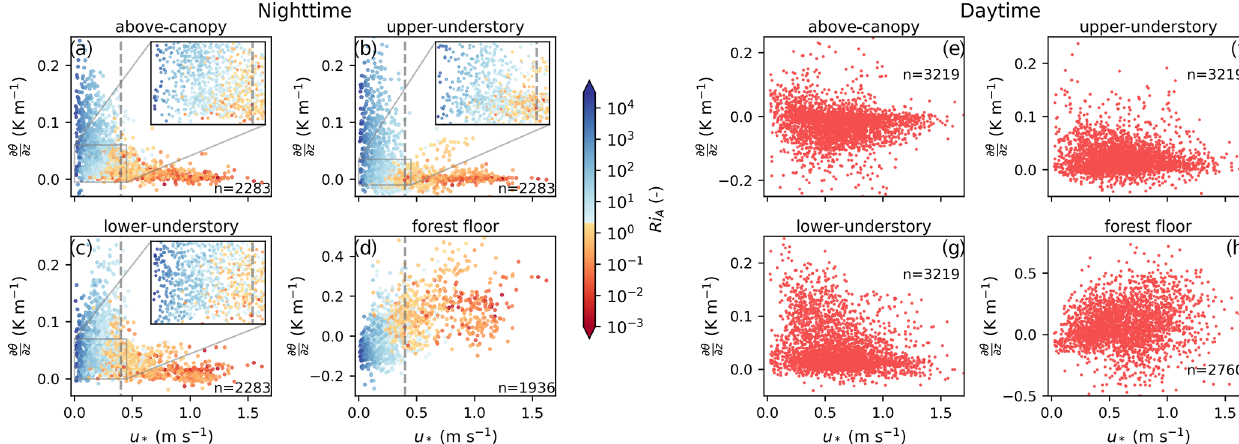
Figure 9. Comparison between the friction velocity at 48m and the DTS-measured temperature gradients. For the nighttime data the markers are colored by the aerodynamic Richardson number, where values of Ri A < 2 (coupled) are colored red and values of Ri A > 2 (decoupled) are colored blue. The vertical dashed gray line indicates u ∗ = 0 . 4. Panels (a) and (e) show the above-canopy gradient, (b) and (f) the upper- understory gradient, (c) and (g) the lower-understory gradient, and (d) and (h) the forest floor